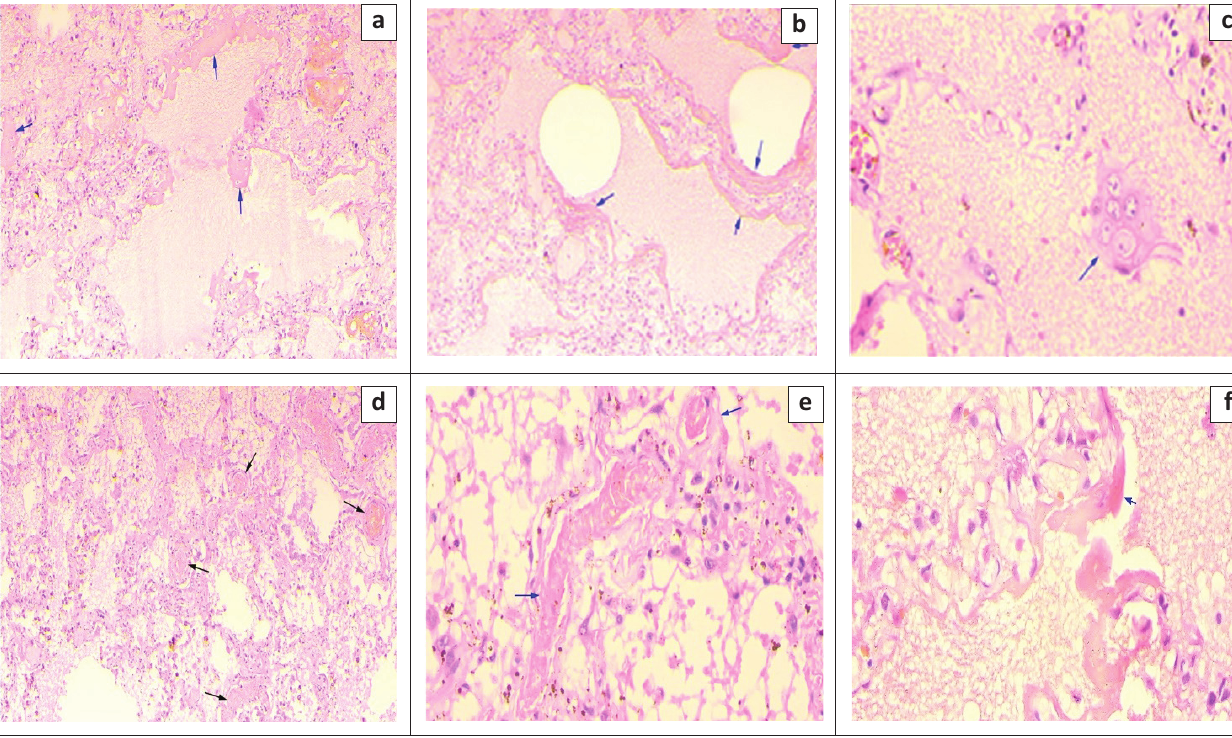
FIGURE 5: Haematoxylin and eosin staining of lung tissue samples from a 55 year old male patient with COVID-19 (37 Military Hospital, Accra, Ghana, May 2020). Case 3: (a) Severe pulmonary oedema, diffuse alveolar damage with hyaline membrane formation (blue arrow) ×100. (b) Severe pulmonary oedema, diffuse alveolar damage with hyaline membrane formation (blue arrow) ×100. (c) Large pneumocytes (blue arrow) ×400. (d) Microthrombi in small pulmonary arteries (black arrows) ×100. (e) Higher magnification (x400) of image (d) showing microthrombi (blue arrow) ×100. (f) Interstitial widening, pulmonary oedema and prominent hyaline membranes (blue